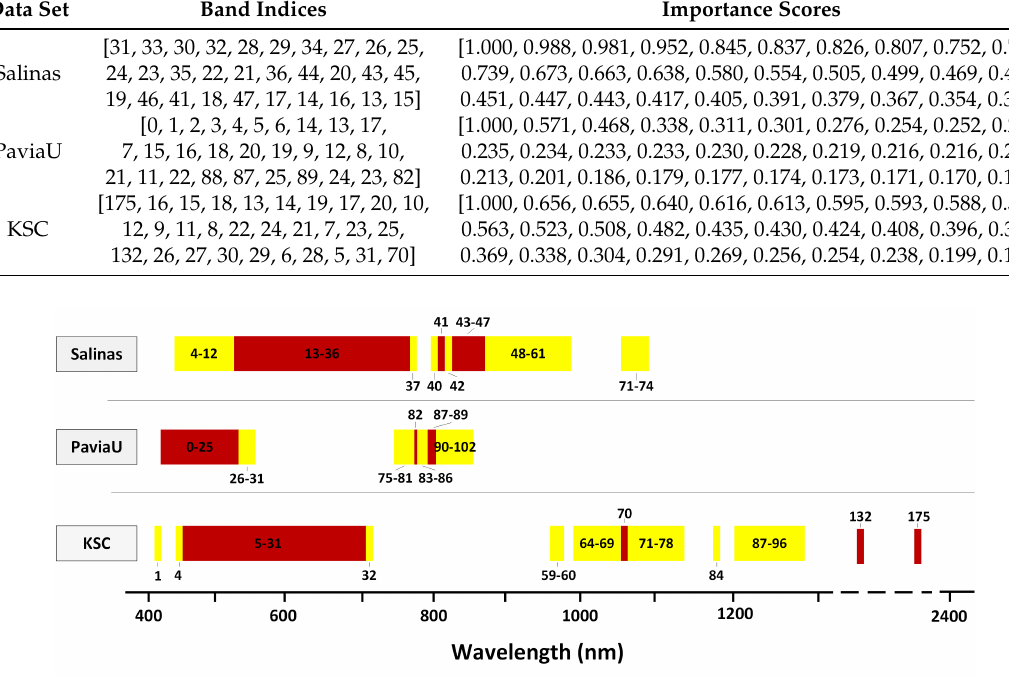
Figure 4. Schematic of band selection using ORF method, where the red part represents the top 30 bands according to importance scores, the yellow part represents the bands with scores ranking from 31 to 60, and the numbers represent the indices of each